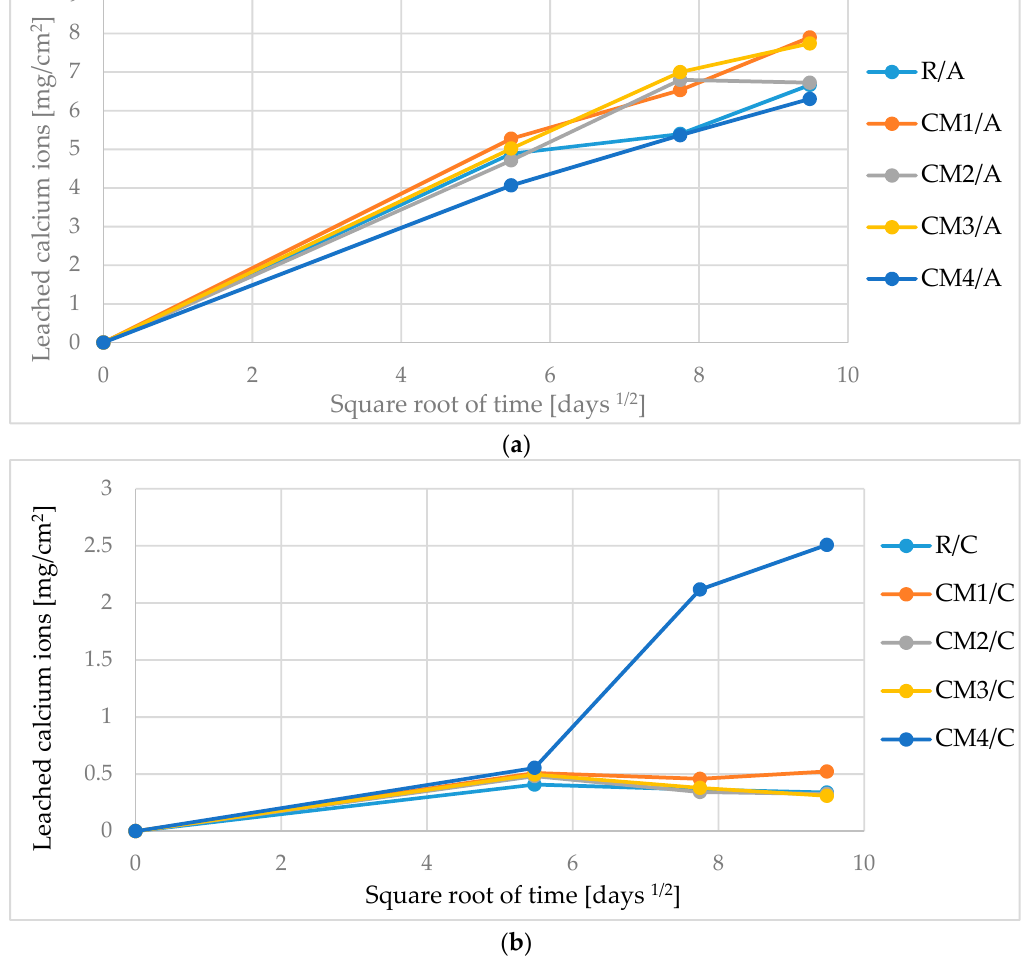
Figure 2. Leached calcium ions in ( a ) in bacterial and ( b ) non-bacterial medium during the 90-day experiment.